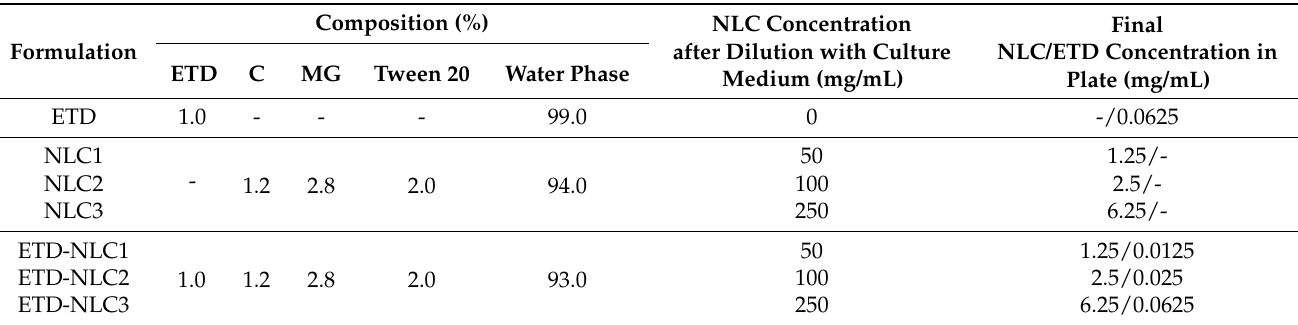
Table 2. Composition of formulations to cytotoxicity